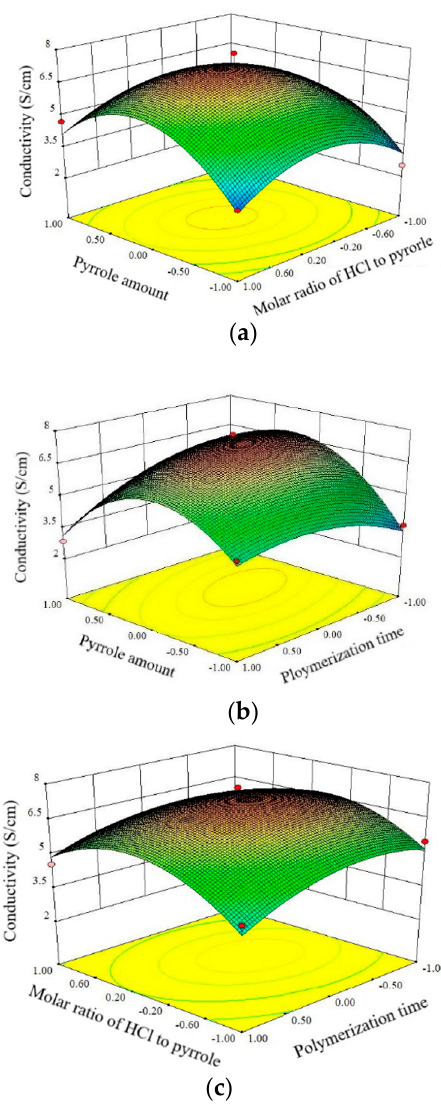
Figure 4. Response surface plots of independent variables on the conductivity of PPy/BC composite: ( a ) pyrrole amount and the molar ratio of HCl to pyrrole; ( b ) pyrrole amount and polymerization time; ( c ) molar ratio of HCl to pyrrole and polymerization time.